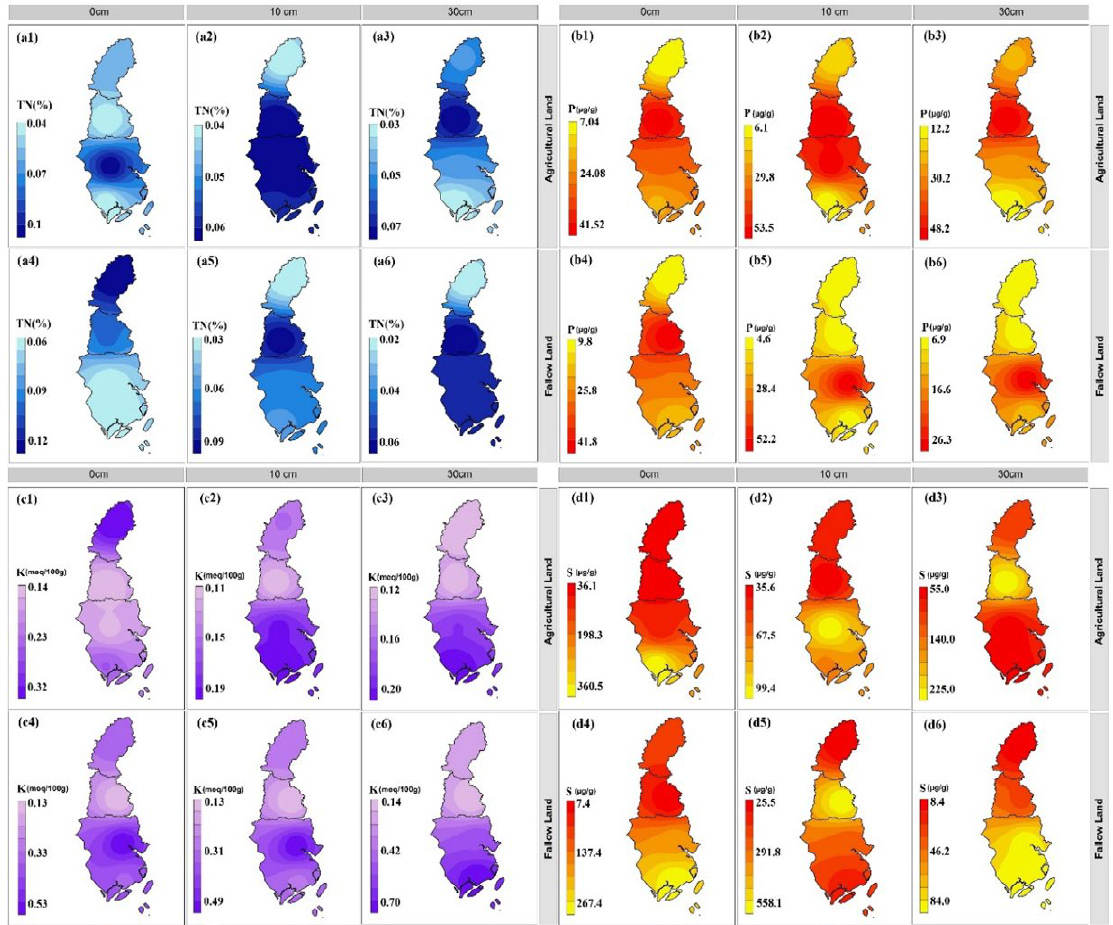
Fig. 7: The changing pattern of TN (a), P (b), K(c) and S (d) along with the distances from the